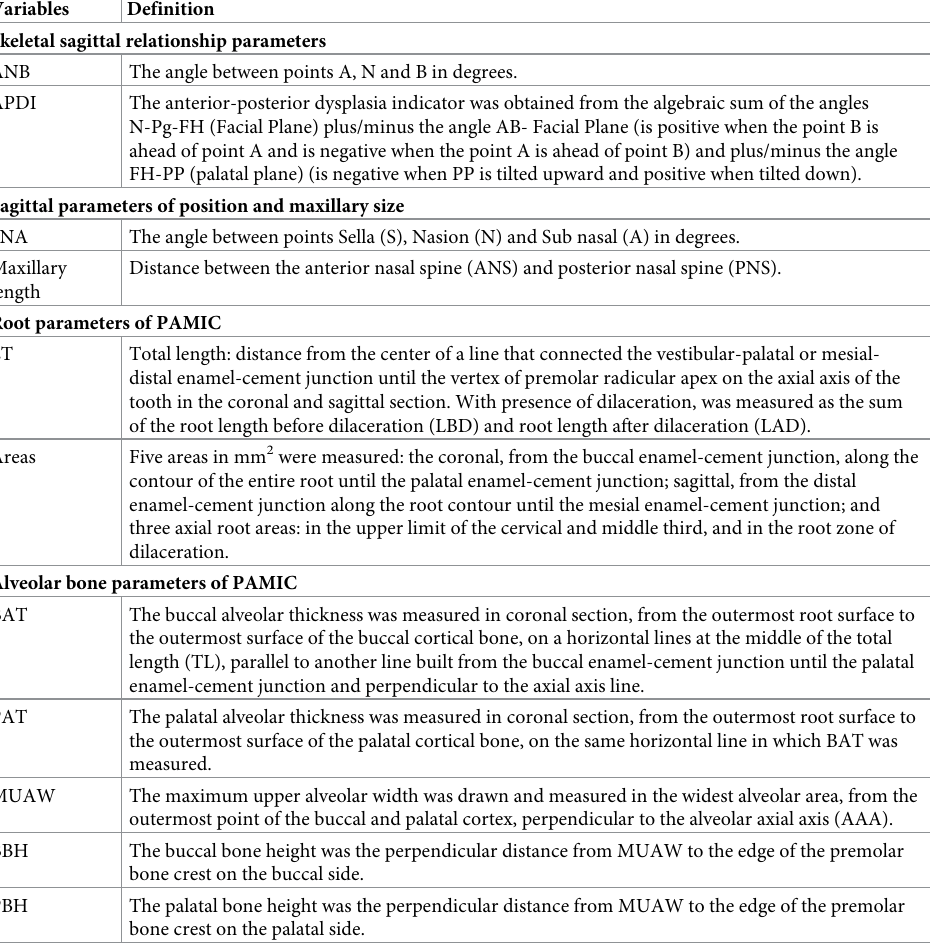
Table 2. Definitions of the measurements used in this